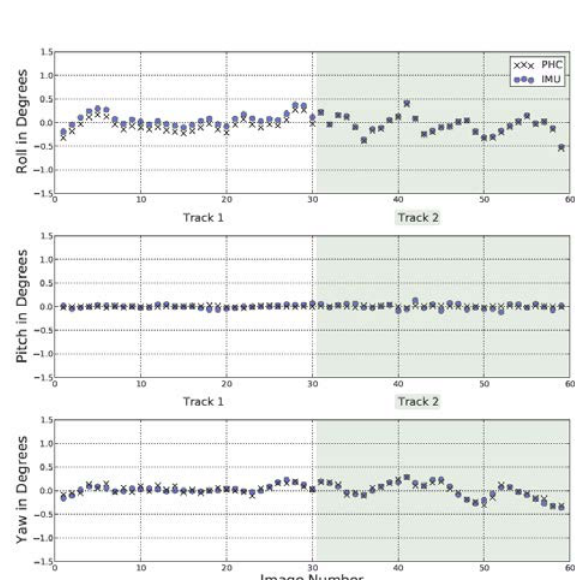
Figure 4. Calculated and measured relative pose angles for track 1 (white) and track 2 (green).